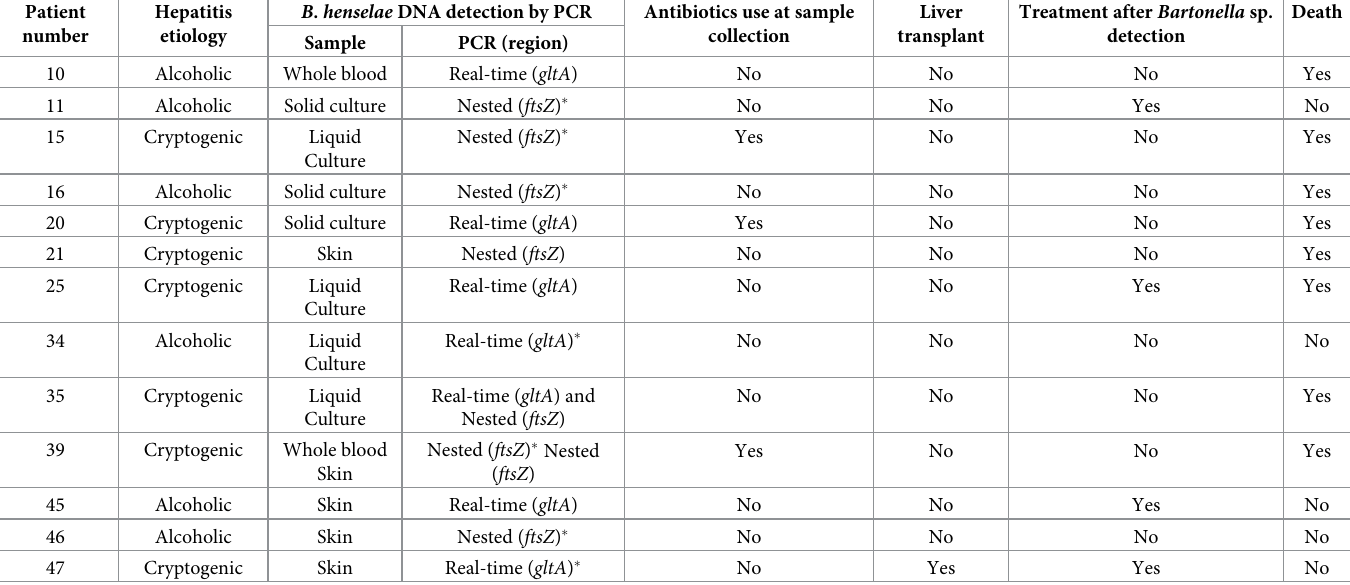
Table 2. Data from patients with non-viral hepatitis and detectable Bartonella henselae -DNA by PCR.